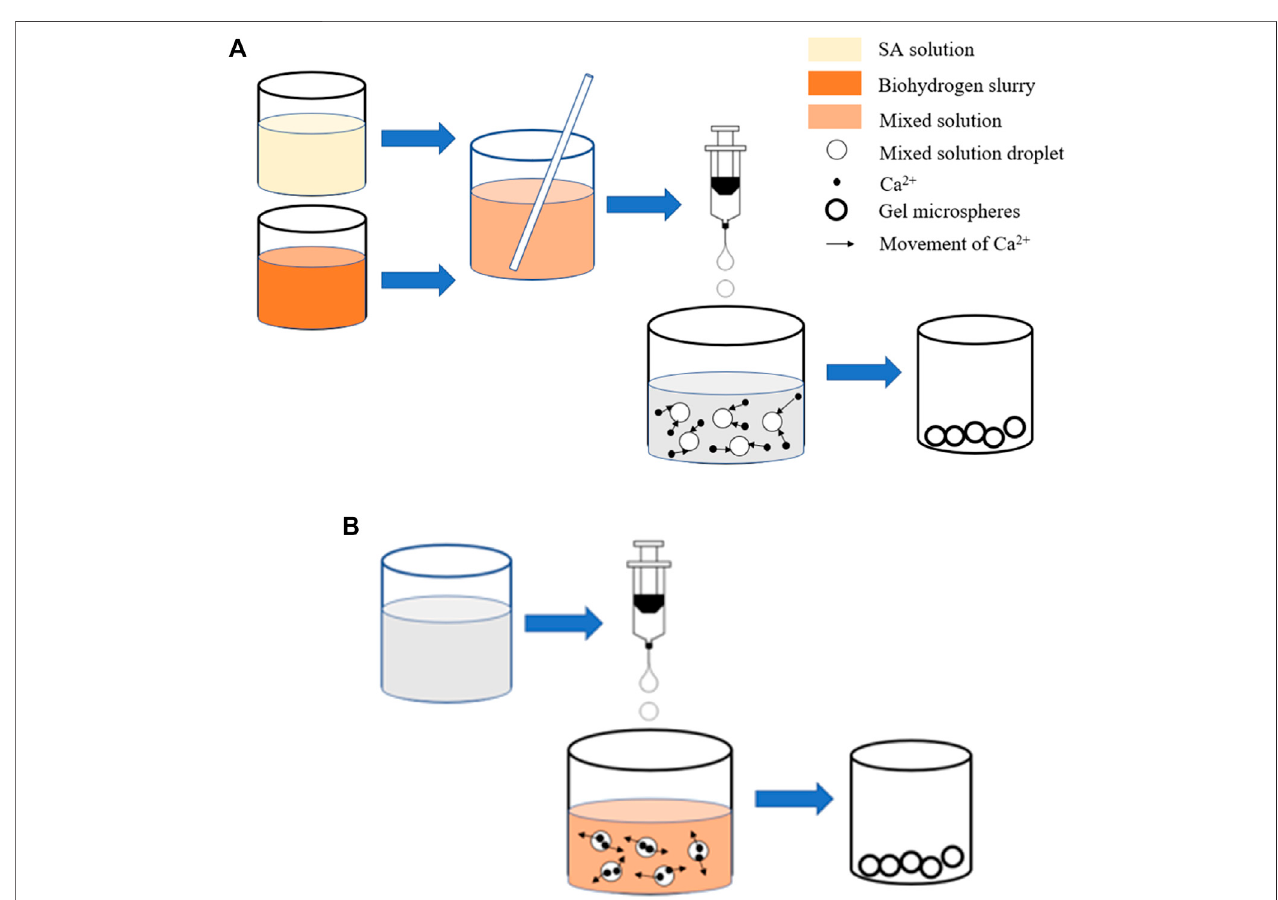
FIGURE 1 | In situ immobilization method of SA. (A) Conventional spheri fi cation. (B) Inverse spheri fi cation.